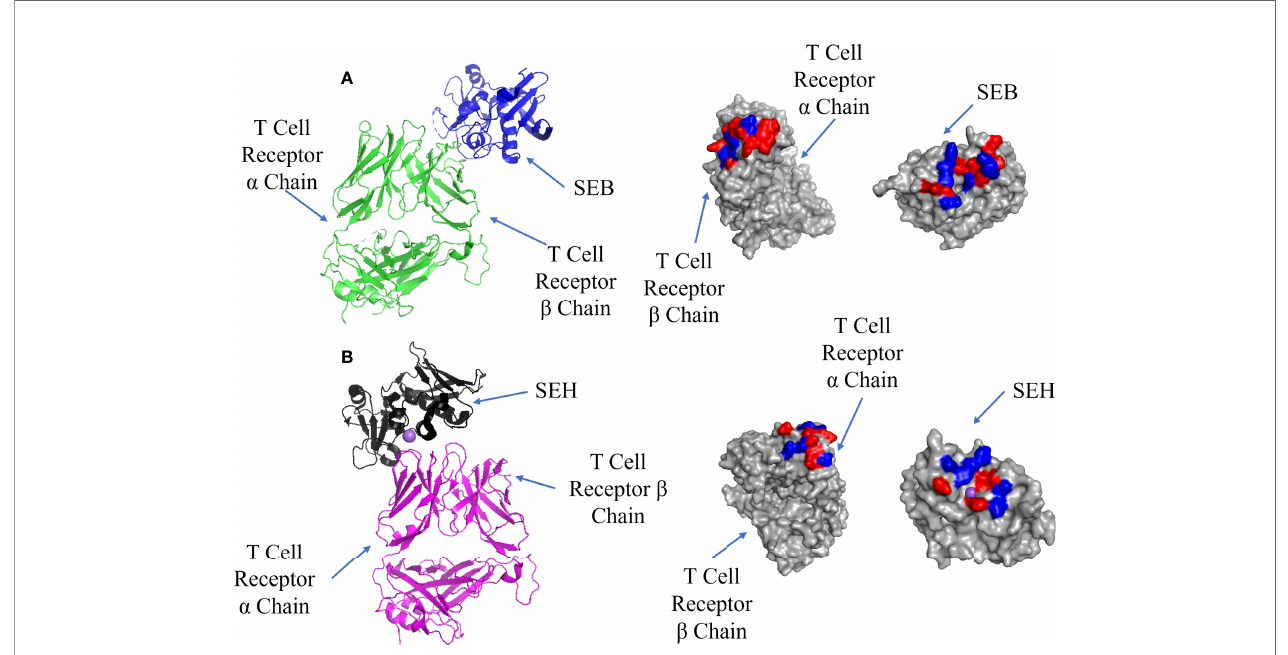
FIGURE 4 | Binding of SEB and SEH superantigens to -TCRs. (A) Left panel: ribbon plot of SEB (blue) bound to TCR (green) (PDB code: 4C56). Middle panel: TCR showing polar (red) and hydrophobic residues (blue). Right panel: SEB. (B) Left panel: ribbon plot of SEH (black) bound to TCR (purple) (PDB code: 2XN9). Middle panel: TCR. Right panel: